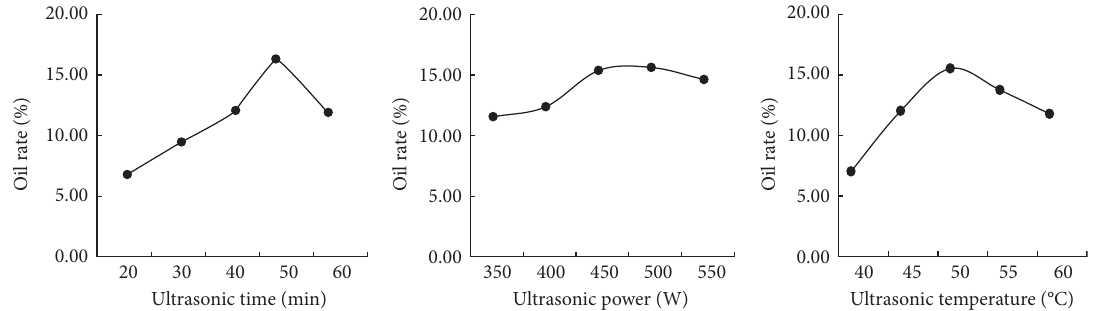
Figure 2: Influence of different factors on the yield of palm seed oil by ultrasound-assisted flash extraction.